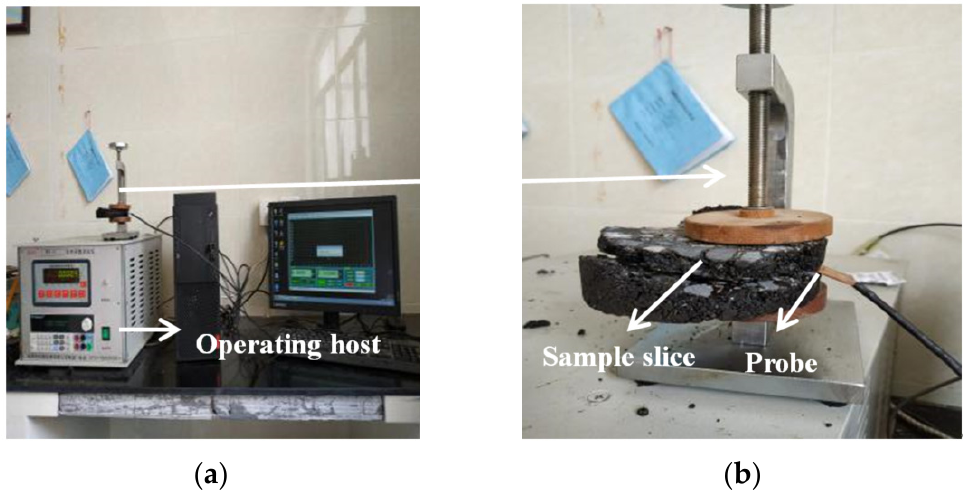
Figure 4. Schematic diagram of thermal conductivity instrument. ( a ) Operating host; ( b ) Measuring sensor.